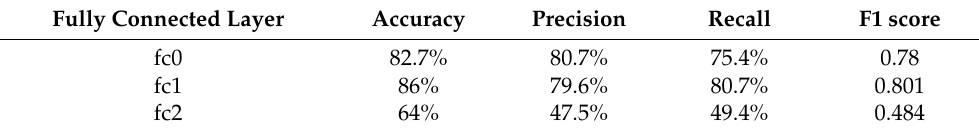
Table 7. Experimental results of DenseNet-DT when DT is connected to different fully connected